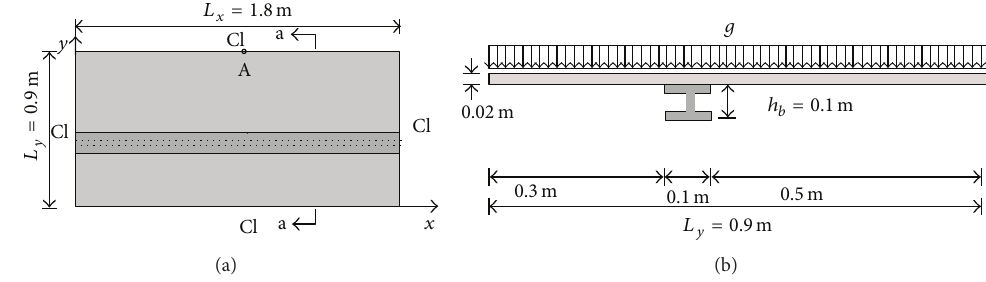
Figure 12: Plan view (a) and section a-a (b) of the stiffened plate of Example 3.